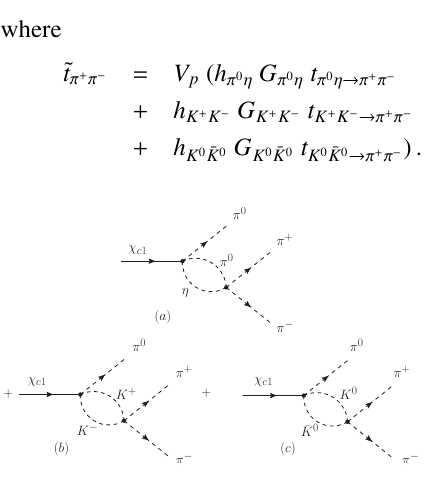
Figure 2. Diagrams involved in the f 0 (980) production in the χ c 1 → π 0 f 0 (980) → π 0 π + π − reaction: rescattering of (a) π 0 η , (b) K + K − , (c) K 0 ¯ K 0